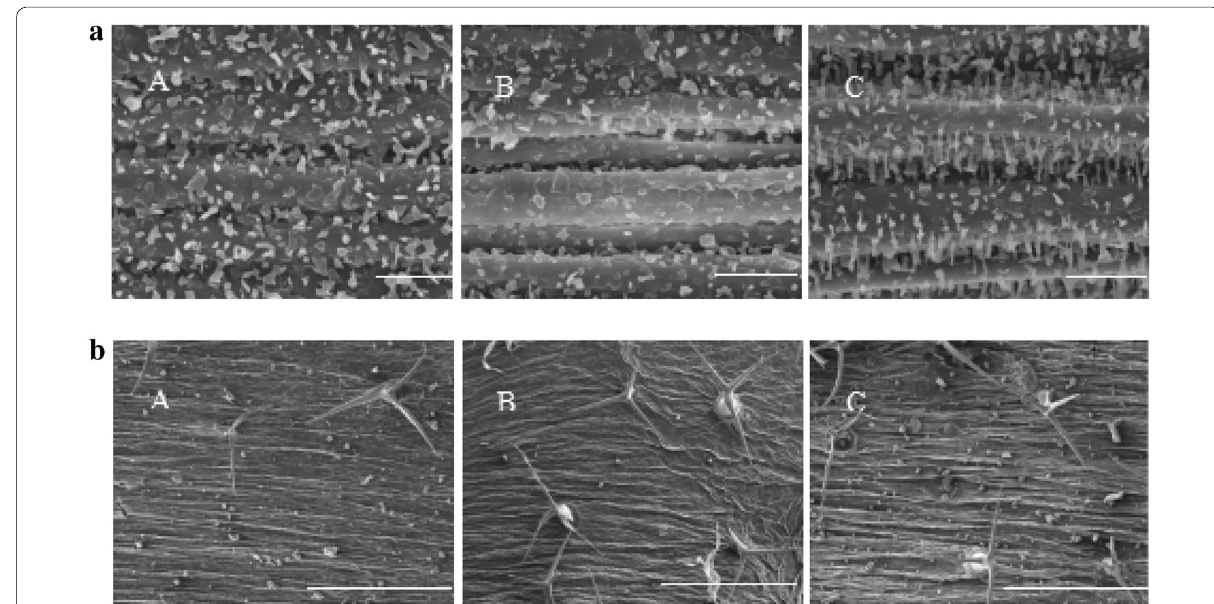
Fig. 2 Scanning electron microscopy images of epicuticular waxes. a Images of the stems in the Col‑0 (A), Atofp8 ‑ 1 (B) and 35S:HA ‑ AtOFP8 (C). Bars 10 µm. b Images of the leaves in the Col‑0 (A), Atofp8 ‑ 1 (B) and 35S:HA ‑ AtOFP8 (C). Bars =